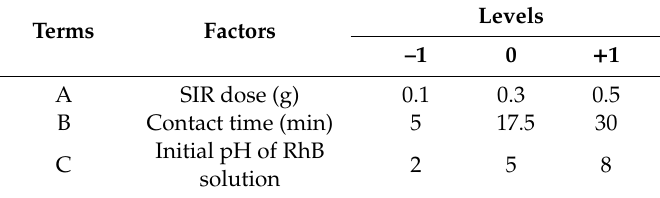
Table 1. Factors, levels, and ranges of the parameters considered for the factorial design. Levels Terms Factors –1 0 + 1 A SIR dose (g) 0.1 0.3 0.5 Contact time (min) Initial pH of RhB C solution